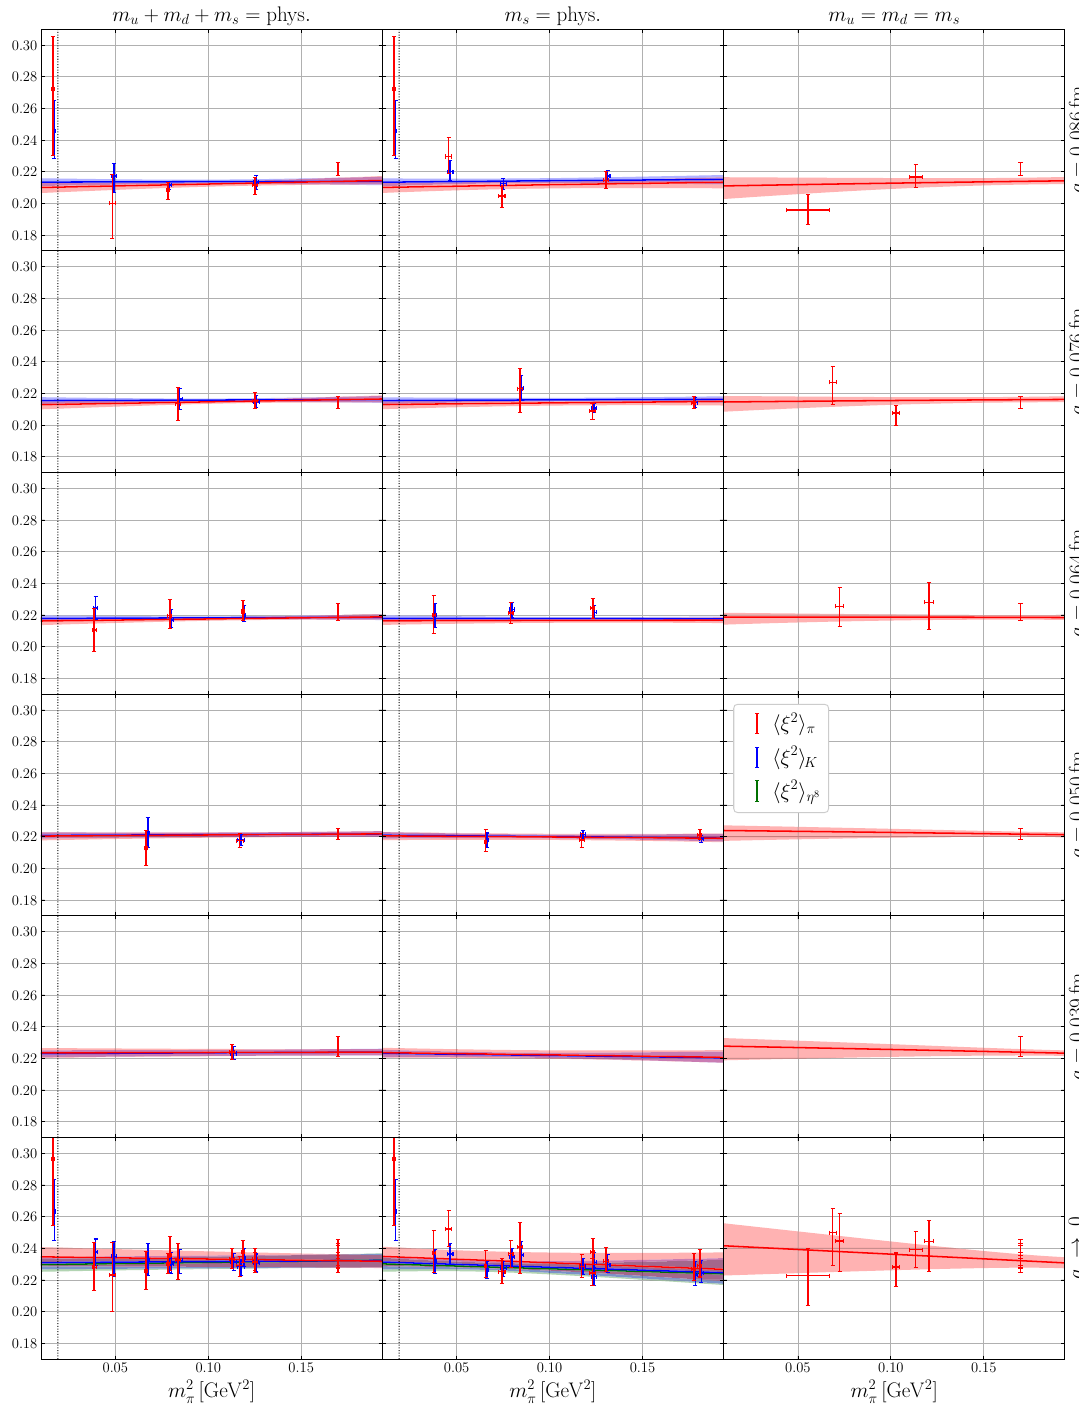
Figure 12 . The pion mass dependence of the moments to bottom) for all lattice spacings as well as in the continuum limit (where, for illustrative purposes, all points have been translated along the fitted function). The columns correspond to the lines of physical average quark mass (left), physical strange quark mass (middle), and symmetric quark masses (right), cf. figure 2. The dotted gray lines mark the physical meson